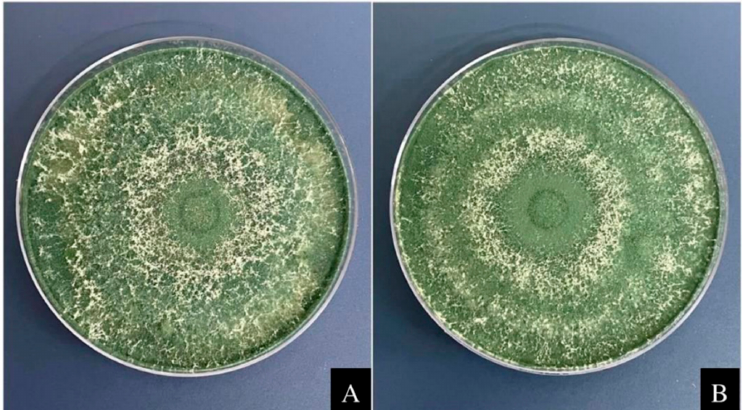
Figure 1. Compatibility between the rock powder and the fungus T. harzianum . The fungus T. harzianum was grown in potato dextrose agar supplemented with 1 g of rock powder and incubated at 28 °C for five days ( A ). Control— T. harzianum was grown in potato dextrose agar medium at 28 °C for five days without rock powder ( B ).